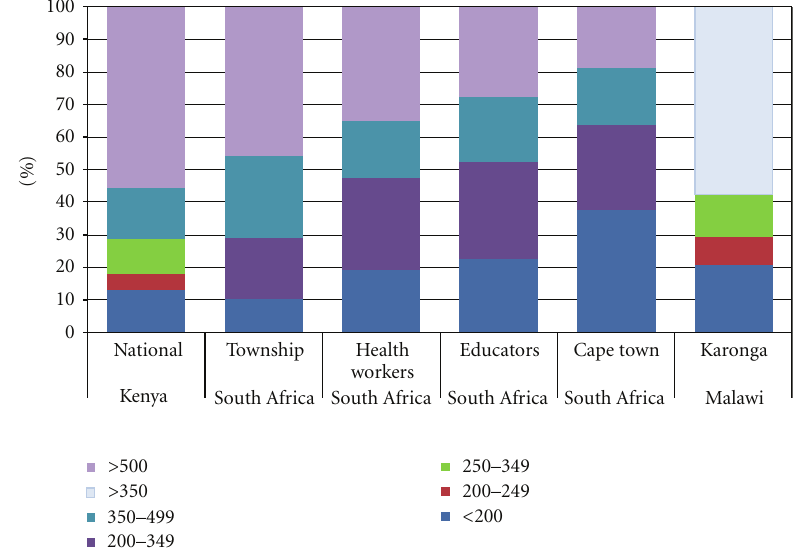
Figure 2: Distribution of HIV+ Population not on ART by CD4